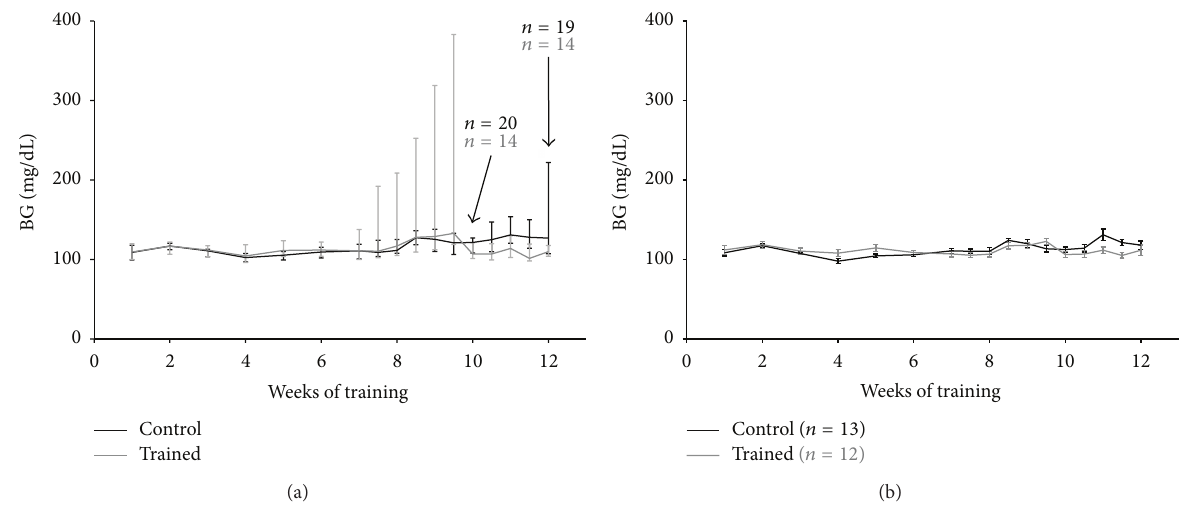
Figure 1: Glycemic profiles over the 12-week exercise training program in all NOD mice (a) and in diabetes-free NOD mice (b). In (a), glycemic values are expressed as median and interquartiles, whereas in (b) data are shown as means and SEM.